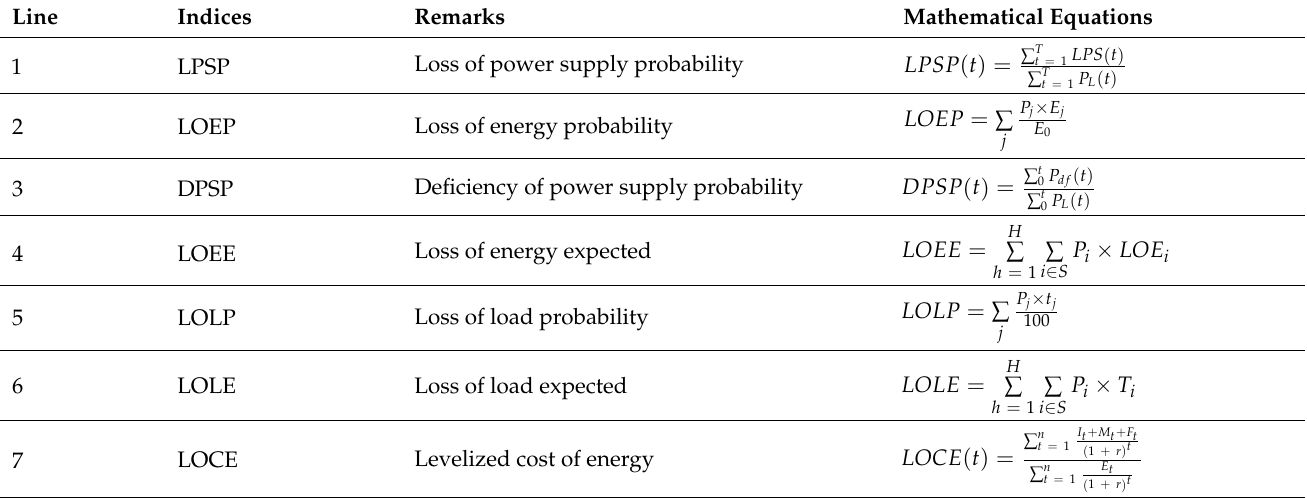
Table 2. The most important reliability indicators used for